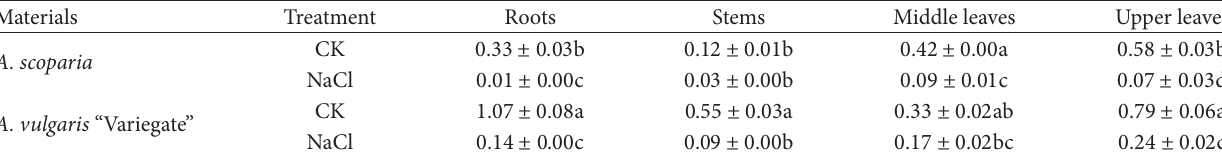
Table 9: Effect of NaCl stress on the ratios of Mg 2+ /Na + in different parts of seedlings. Materials Treatment